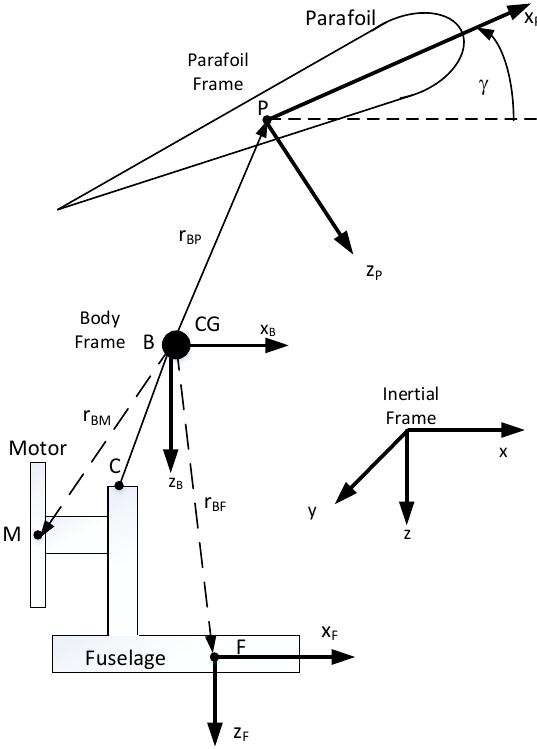
Figure 2. PPC coordinate system.